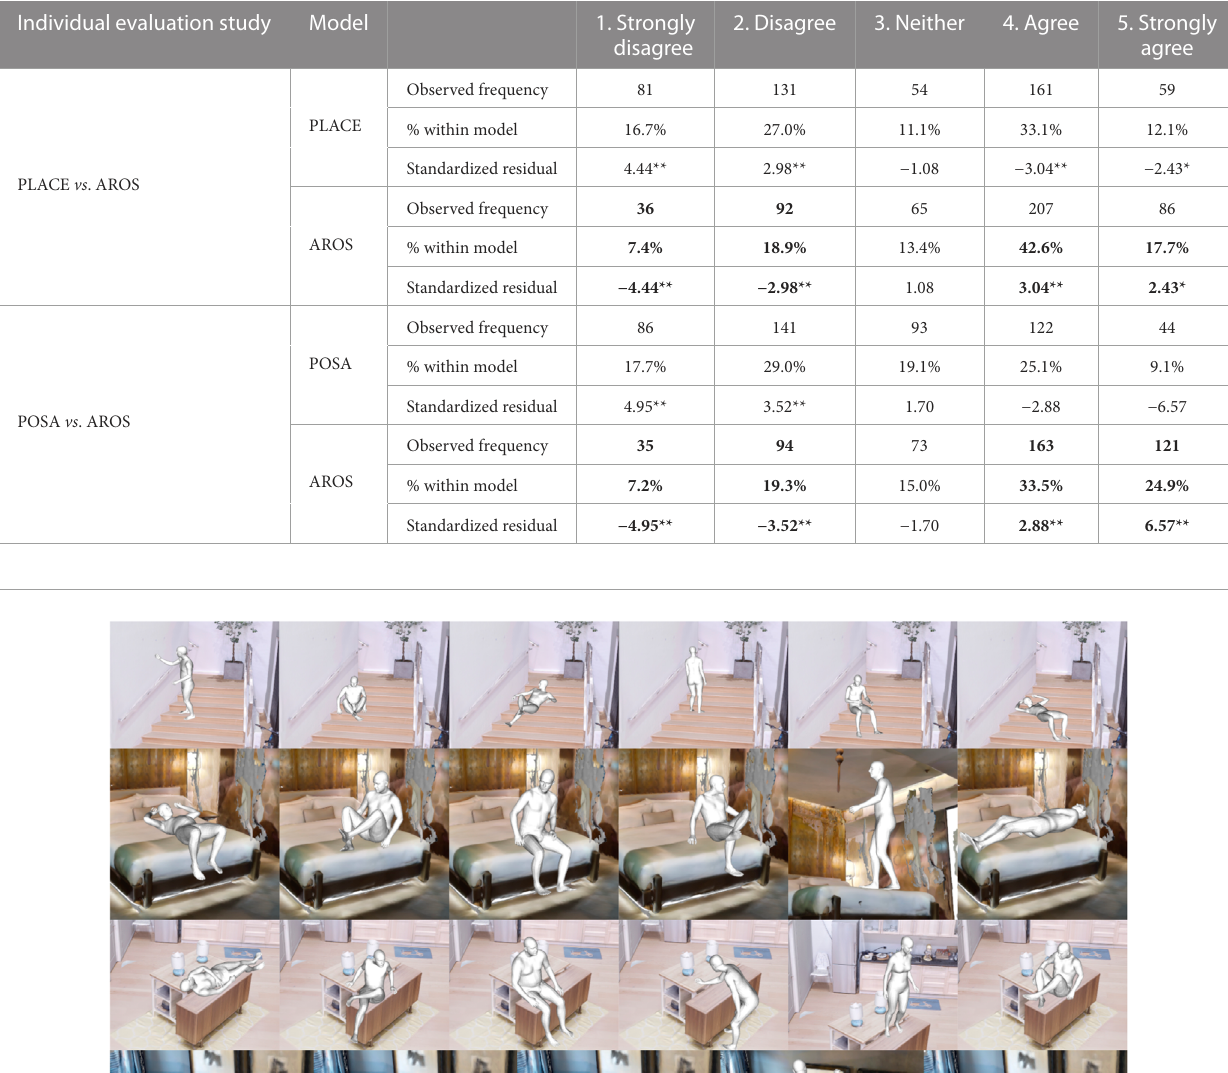
TABLE5 Cross-tabulationdataofindividualevaluationstudiesonchallenginglocations.Achi-squaretestofhomogeneityondataprovidesevidenceof differenceinthedistributionofscoreswith α = 0 . 05 .Ananalysisofresidualindicatesthesourceofsuchdifferences,anasterisk(*)indicatesconservative statisticalsignificanceat α = 0 . 05 ,andadoubleasterisk(**)denotesstatisticalsignificancewith α adj = 0 . 005 .Thebestareinboldface. Individual evaluation